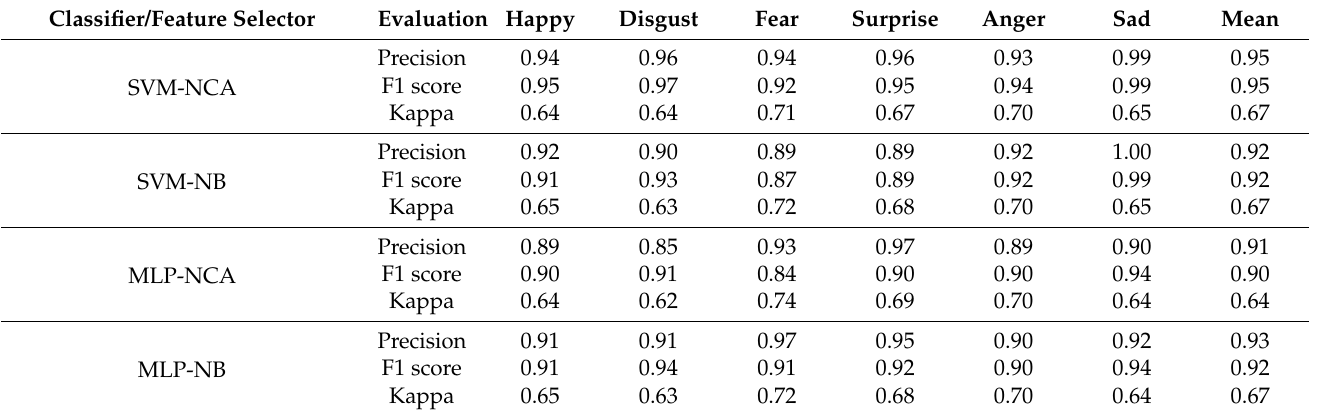
Table 2. Precision, F1 score, and Kappa statistical evaluation method reported from classification human affective state recognition based on six main ROIs and SVM, MLP classifiers with NCA and NB feature selection algorithms.